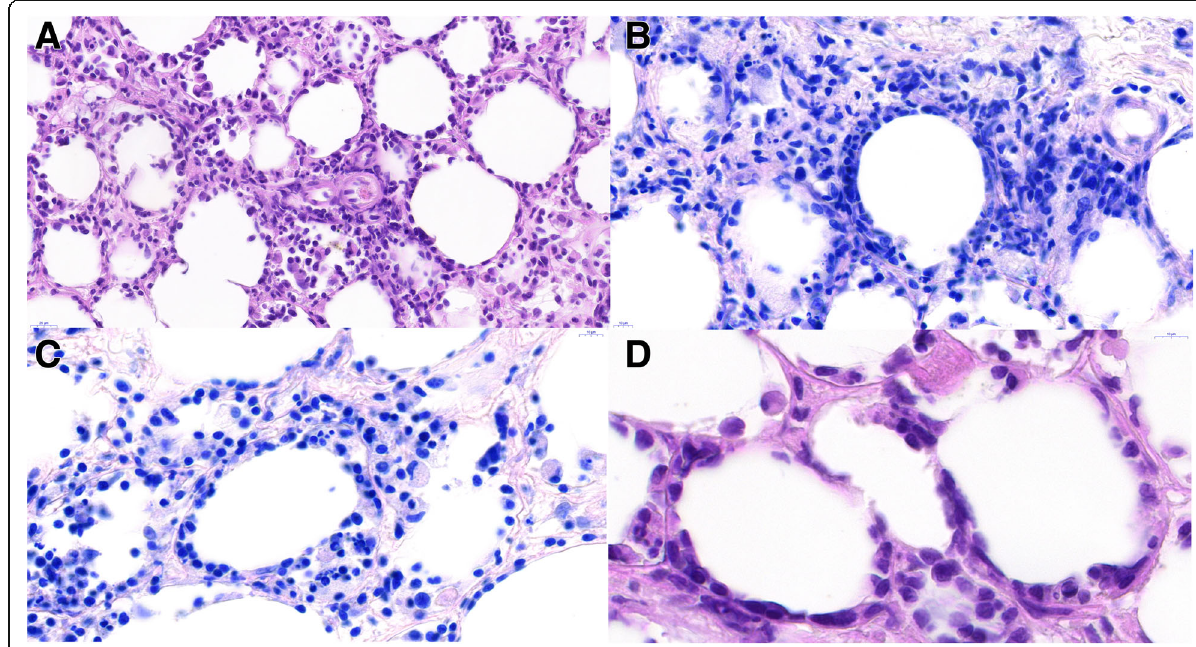
Fig. 2 scans of histological slides from the mesenterial fat tissue showing dense lymphocytic infiltration consisting mostly of medium-sized cells with hyperchromatic irregular nuclei. Note a pattern of isolated adipocytes surrounded by a rim of lymphocytes ( “ rimming ” ) and large macrophages engulfing lymphocytes (hemophagocytosis). A – HE 60x, B – Giemsa 85x, C – Giemsa 105x, D – HE